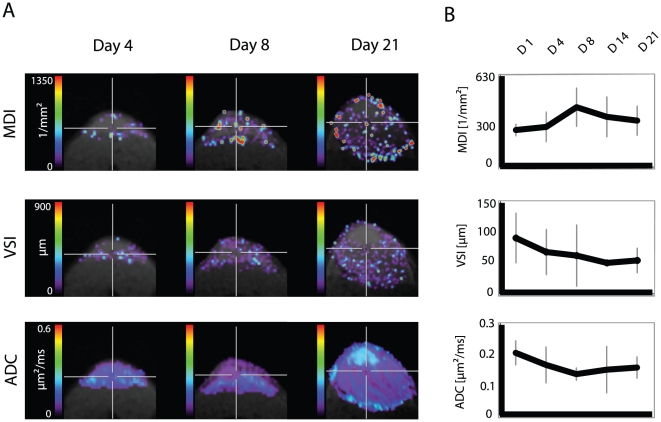
Longitudinal investigation of vascular dynamics during tumor growth.Simultaneous in vivo monitoring of tumor depiction with T2-weighted imaging, microvessel density (MDI), vessel size (VSI) and apparent diffusion coefficient (ADC) during tumor growth on day 1, day 4, day 8, day 14, and day 21 (D1, D4, D8, D14, D21).